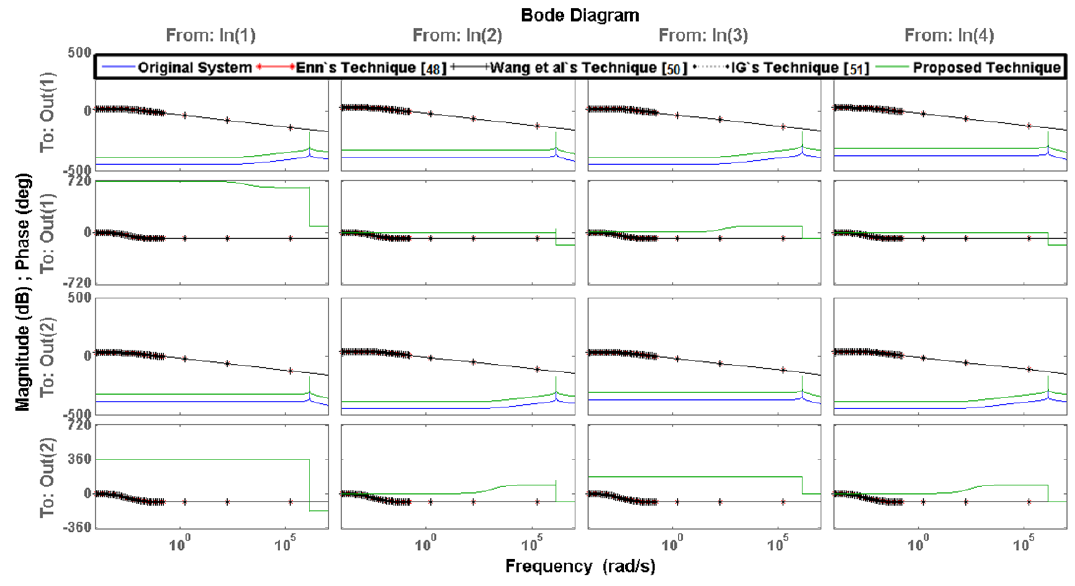
Figure 5. Frequency response Bode plot (magnitude and phase) in the given frequency weights of 1st order for Example 1.